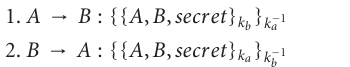
Table 1: Example of increasing protocol.